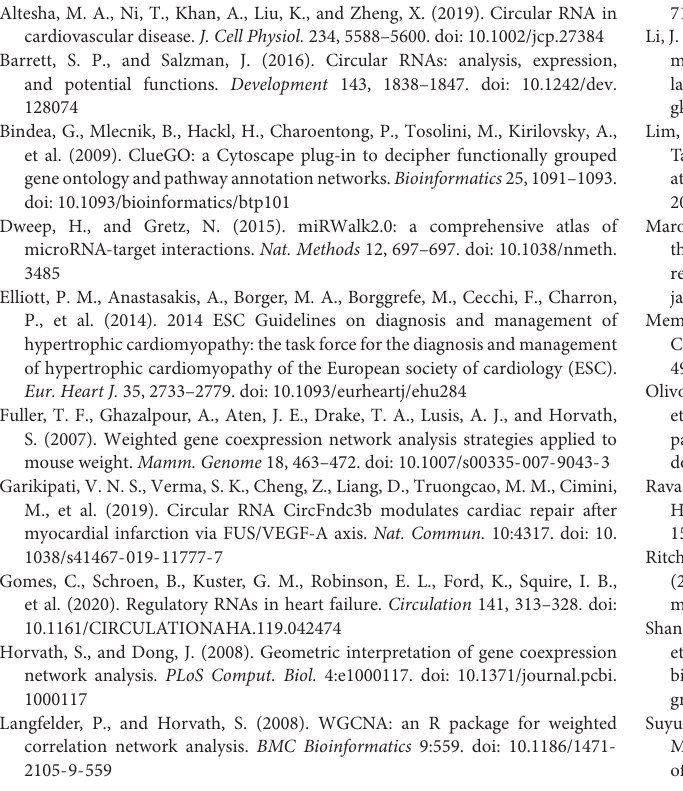
were calculated and showed for each association. GS, gene significance; MM, module membership; HCM, hypertrophic cardiomyopathy; cor, correlation coefficient.